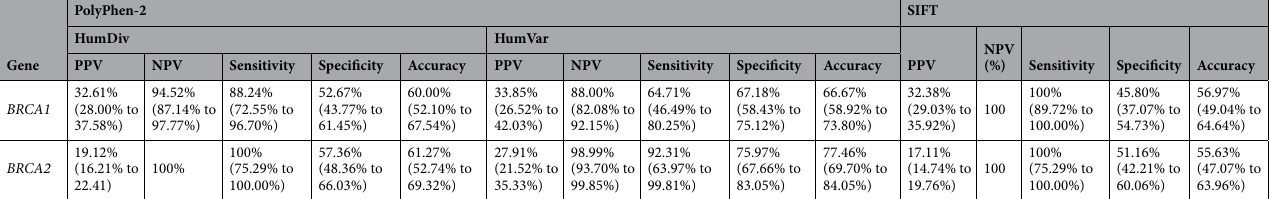
Table 1. Calculations of positive predictive value (PPV), negative predictive value (NPV), sensitivity, specificity, and accuracy for BRCA1 (N = 131 Benign, N = 34 Pathogenic) and BRCA2 (N = 129 Benign, N = 13